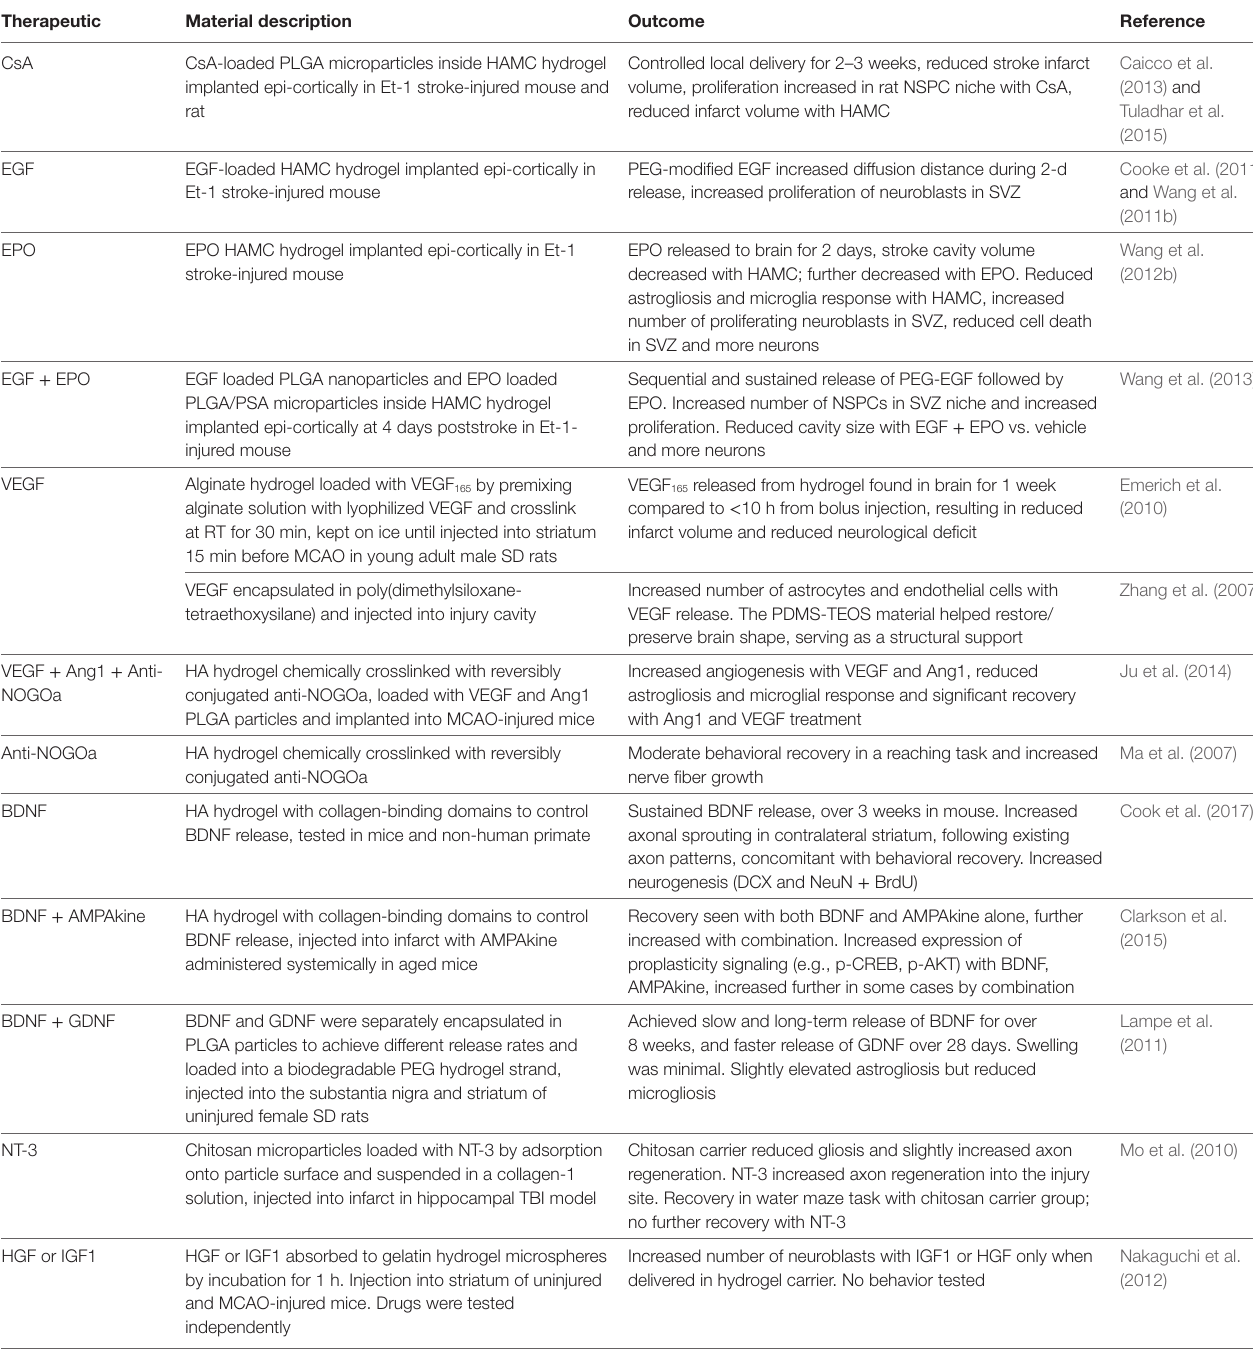
TABLe 1 | Biomaterials for local drug delivery to the brain.